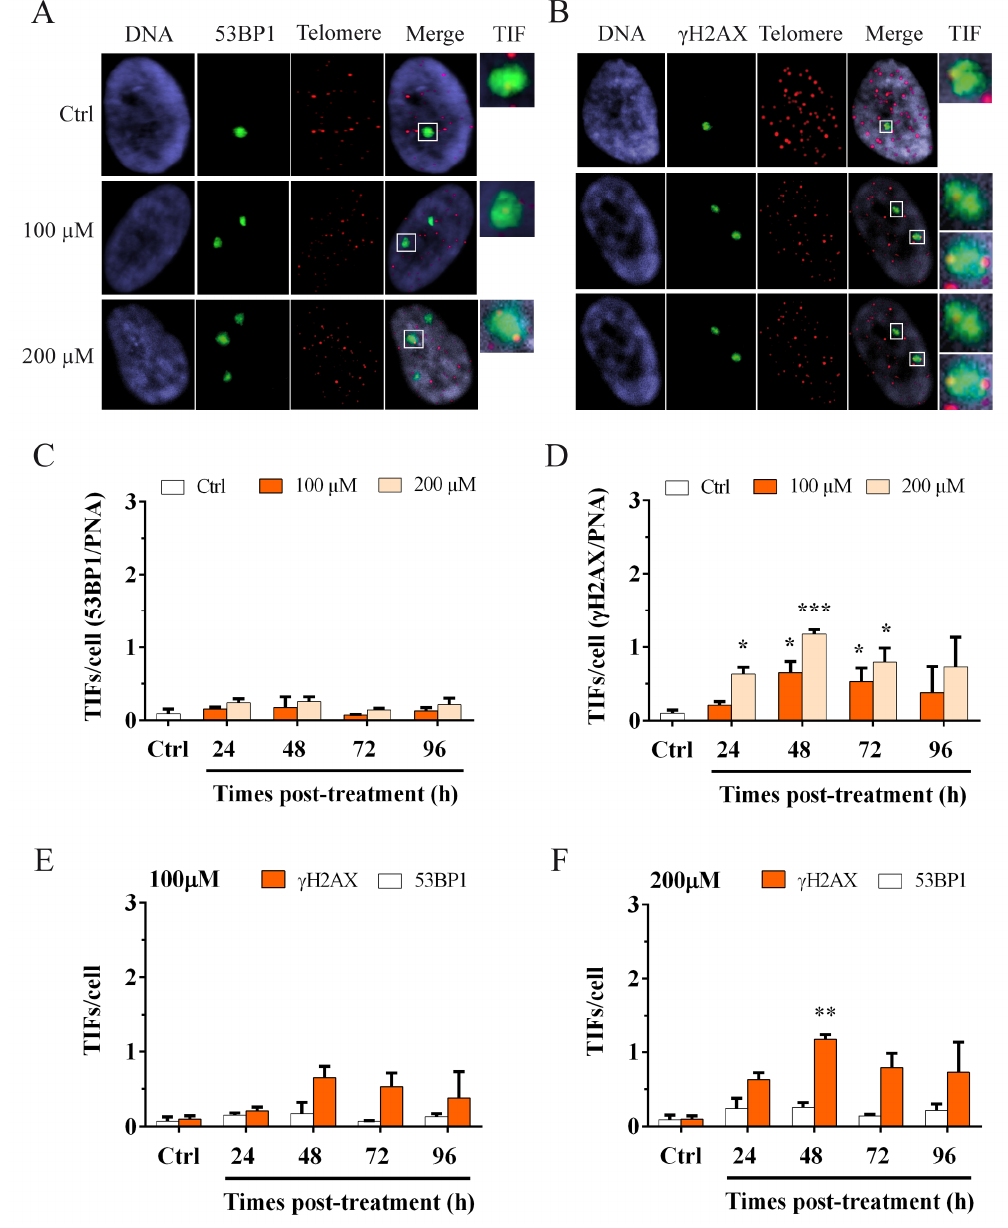
Figure 4. ImmunoFISH staining to detect telomere dysfunction-induced 53BP1 and γ H2AX foci (TIFs). Images of MRC-5 cells stained for ( A ) 53BP1 foci and the telomeric PNA probe and ( B ) γ H2AX foci and the telomeric PNA probe. The colocalization of both signals (green and red spots) indicates the presence of a telomere dysfunction-induced focus (TIF). More than a one telomeric signal can colocalize with 53BP1 or γ H2AX foci (as shown in Figure 4A and 4B-TIF). TIF (last boxes) are enlarged to show the colocalization between 53BP1 and telomeres ( A ) and between γ H2AX and telomeres ( B ). ImmunoFISH staining was used to detect the activation of the DDR at telomeres. The graphs represent the results of telomeric damage after oxidative stress at different times post-treatment. Two markers of DNA damage were used in the analysis. ( C ) 53BP1 TIFs. The columns show data obtained by colocalization between 53BP1 foci and telomeres per cell. We observed no differences in treated and untreated samples for both doses of hydrogen peroxide at different times post-treatment. ( D ) γH2AX TIFs. The columns show data obtained by colocalization between γH2AX foci and the telomeres per cell. We observed a significant increase ( p < 0.05) of foci at